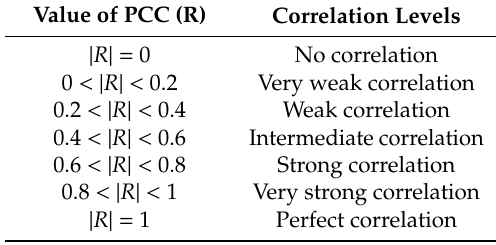
Table 2. The Pearson correlation coe ffi cient (PCC) value (R) and corresponding correlation